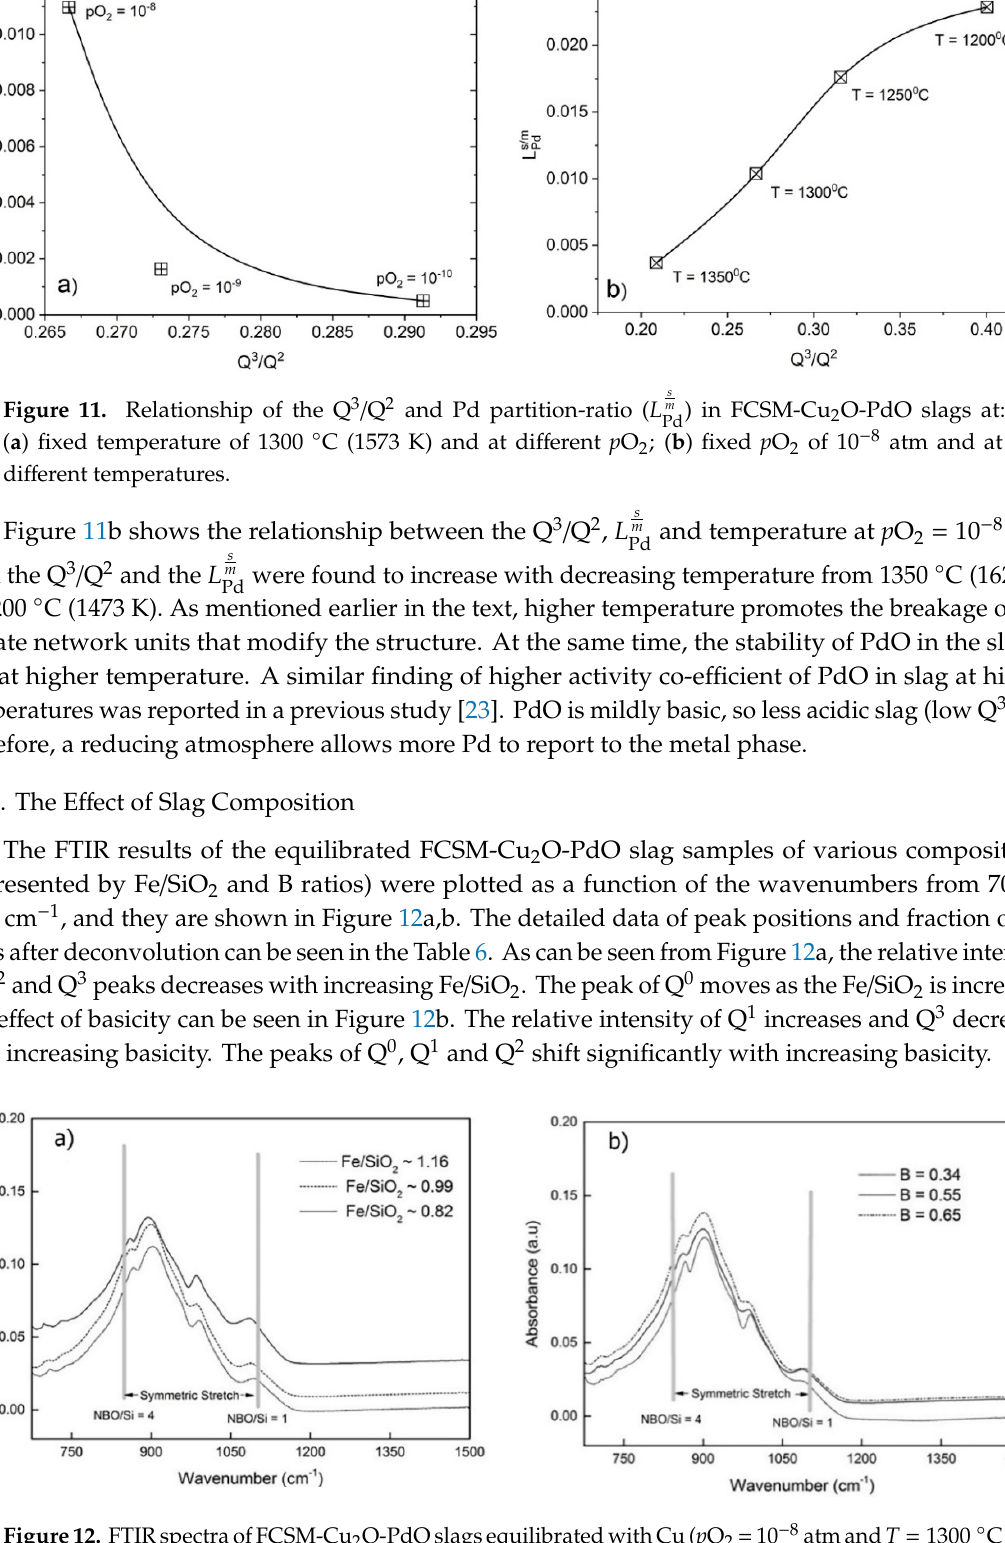
15 of 23 Figure 10. Deconvolution results of FTIR spectra of FCSM-Cu 2 O-PdO slags for samples equilibrated at ( a ) p O 2 = 10 − 9 , T = 1300 °C (1573 K); ( b ) p O 2 = 10 − 10 , T = 1300 °C (1573 K); ( c ) p O 2 = 10 − 8 , T = 1200 °C (1473 K); and ( d ) p O 2 = 10 − 8 , T = 1300 °C (1573 K). The structure of the FCSM-Cu 2 O-PdO slags were correlated with the Pd partition ratio, 𝐿 (cid:2900)(cid:2914)(cid:2929) (cid:2923)⁄ , at different conditions ( p O 2 and temperature). Figure 11a shows the change in Q 3 /Q 2 of the FCSM-Cu 2 O- PdO with 𝐿 (cid:2900)(cid:2914)(cid:2929) (cid:2923)⁄ and p O 2 at 1300 °C (1573 K). Increasing the p O 2 from 10 − 10 to 10 − 9 atm, did not appear to increase the 𝐿 (cid:2900)(cid:2914)(cid:2929) (cid:2923)⁄ significantly; although increasing to this oxygen potential was accompanied by a decrease of Q 3 /Q 2 . Further increase in p O 2 to 10 − 8 atm, however, increased the 𝐿 (cid:2900)(cid:2914)(cid:2929) (cid:2923)⁄ significantly. This may suggest that at this p O 2 range, there was enough oxygen in the gas phase that allowed the incorporation of the oxygen atom into the silicate network units to form new bonds. Figure 11b shows the relationship between the Q 3 /Q 2 , 𝐿 (cid:2900)(cid:2914)(cid:2929) (cid:2923)⁄ and temperature at p O 2 = 10 − 8 atm. Both the Q 3 /Q 2 and the 𝐿 (cid:2900)(cid:2914)(cid:2929) (cid:2923)⁄ were found to increase with decreasing temperature from 1350 °C (1623